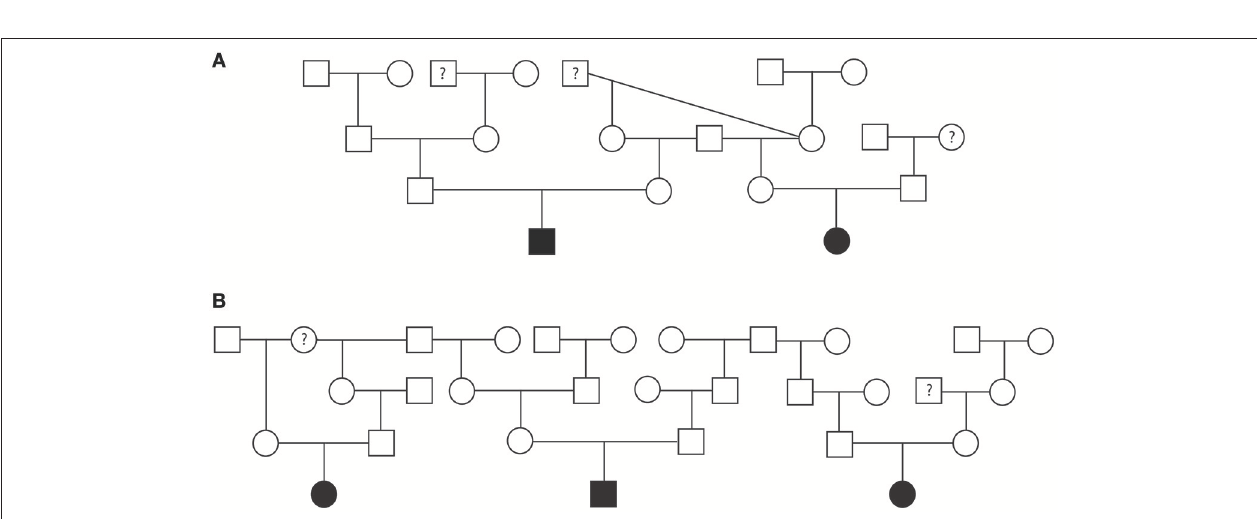
FIGURE 4 | Pedigree representing two families of Golden Retrievers that were phenotyped for subvalvular aortic stenosis (SAS). (A) Represents first family. (B) Represents the second family. Affection status is represented as follows: squares represent males, circles represent females, open symbols are SAS unaffected, gray symbols are SAS equivocal, black symbols are SAS affected, and symbols with questions marks have unknown SAS cardiac status.